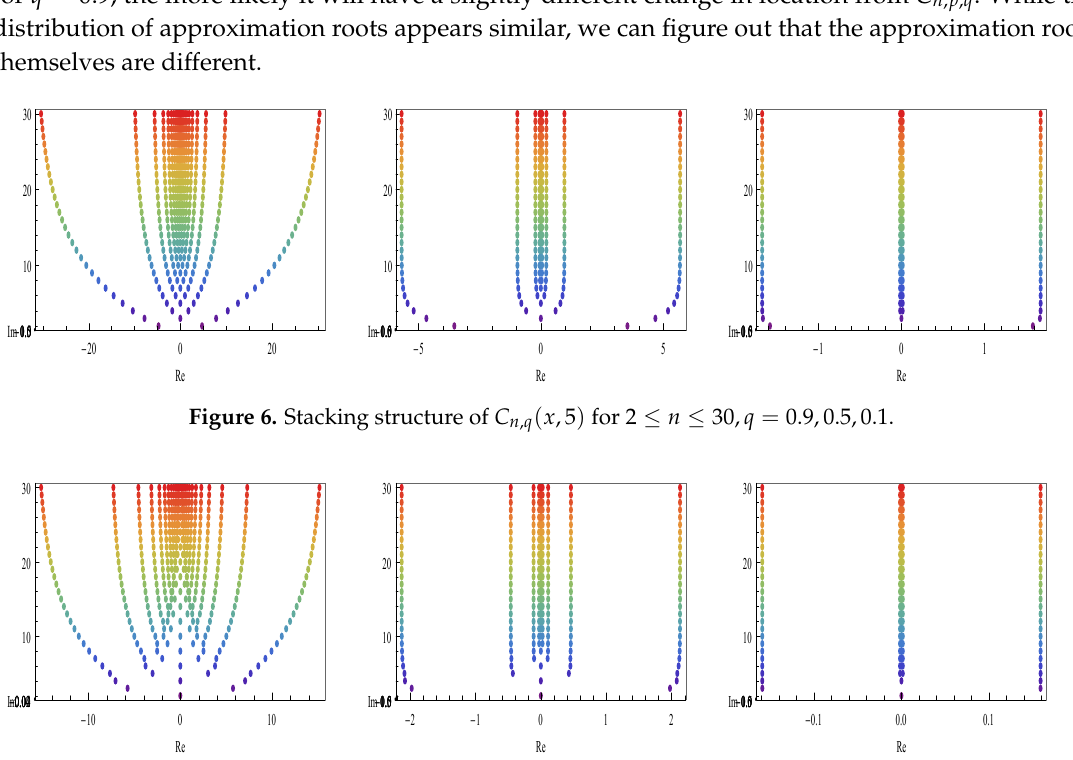
Figure 7. Stacking structure of S n , q ( x ,5 ) for 2 ≤ n ≤ 30, q =